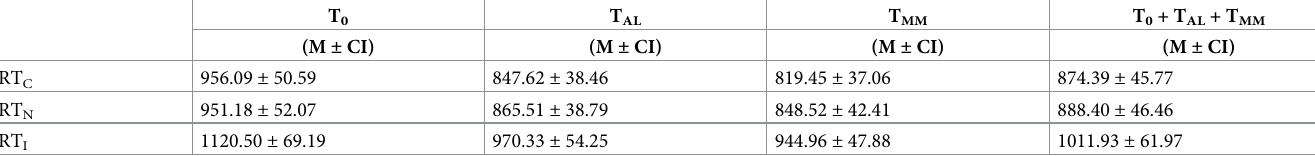
Table 3. Stroop task mean reaction times (RT) for all participants (meditators and novices combined) across